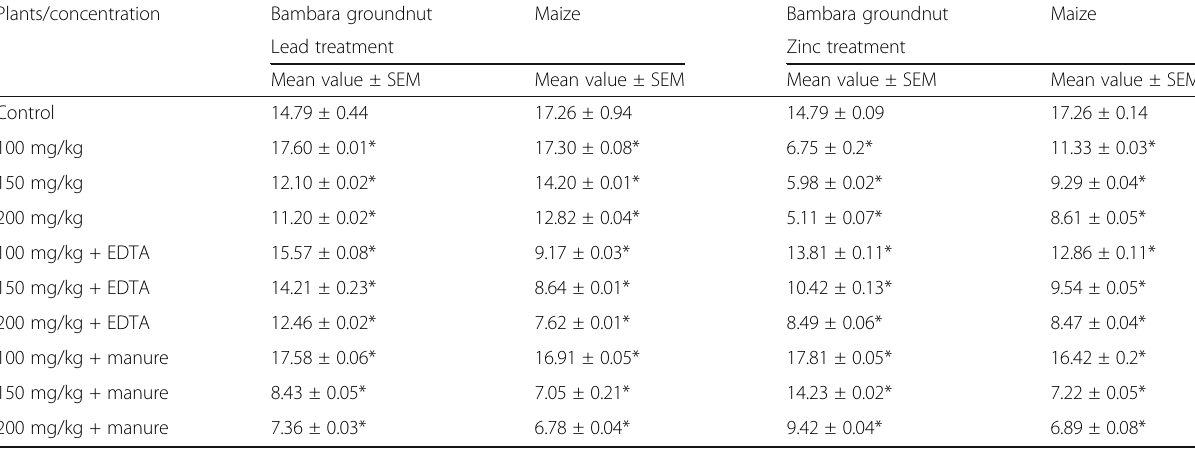
Table 4 Effect of lead and zinc concentration on the total carbohydrate of the test plants Plants/concentration